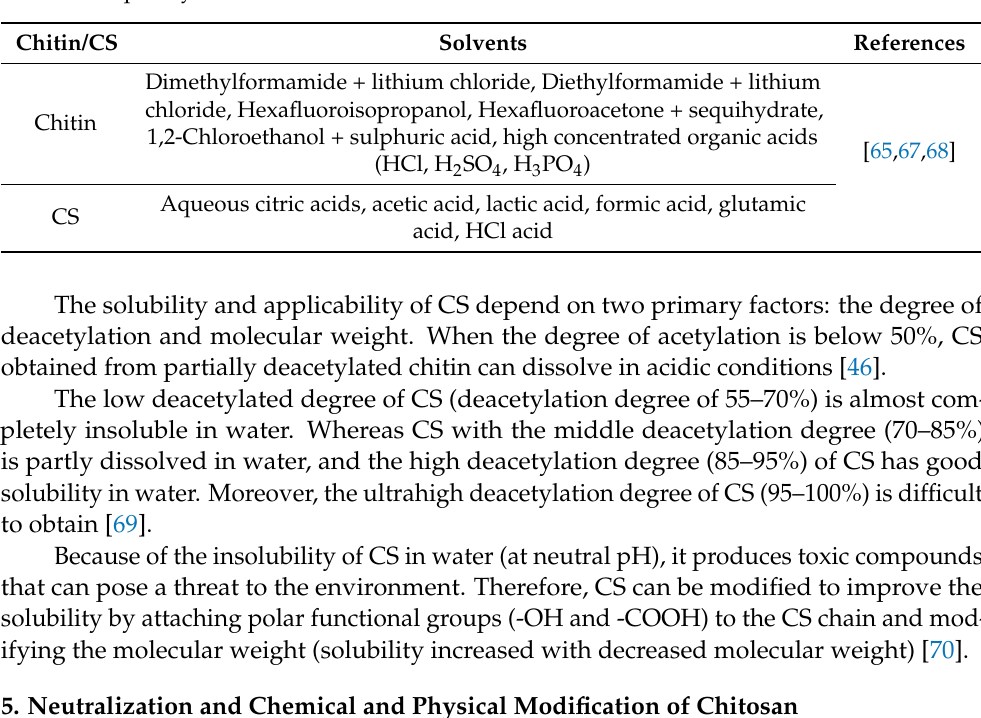
Table 3. Frequently used solvents for chitin and